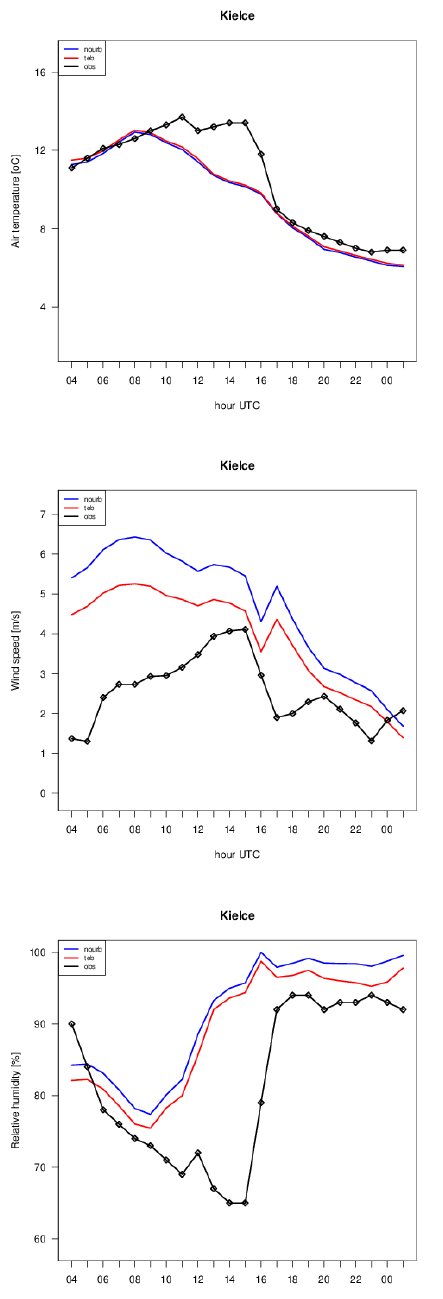
Figure 6 Comparison of modelled NO concentrations with observations from station Fig. 6. Comparison of modelled NO 2 concentrations with observa- 2 tions from station Kielce, Wroclaw-Bartnicza, Warsaw-Targowek Kielce, Wroclaw-Bartnicza, Warsaw-Targowek for 6 th of November 2010 (red line – for 6 November 2010 (red line - urban scenario, blue line - non- urban scenario, black line - urban scenario, blue line = non-urban scenario)